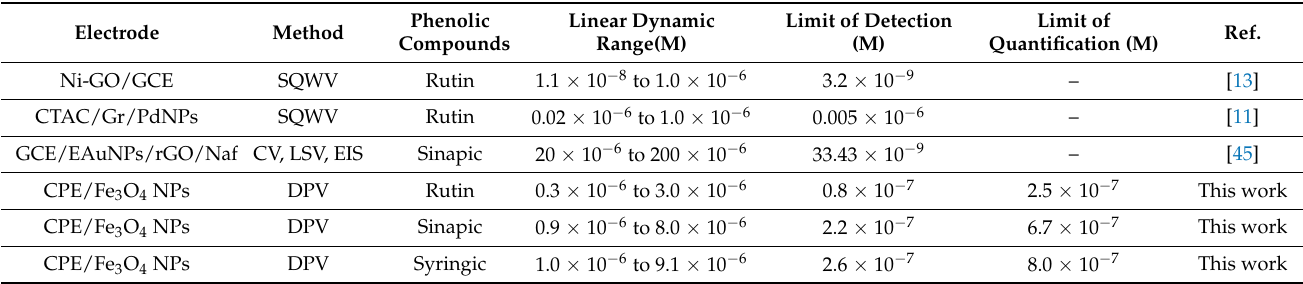
Table 4. Limits of detection (LOD) and limit of quantification (LOQ) reported for the differential pulse voltammetry method employed in detecting phenolic compounds compared to other methods